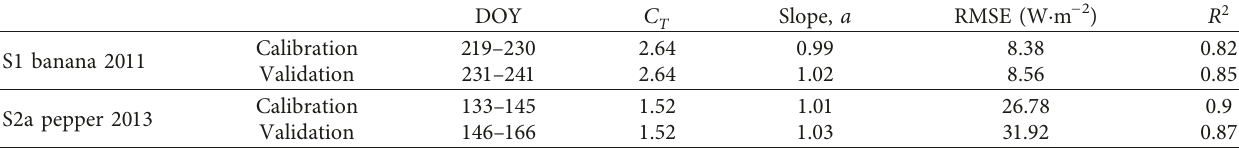
Results are presented for the miniature thermocouple positioned at the height that provided the best performance in each